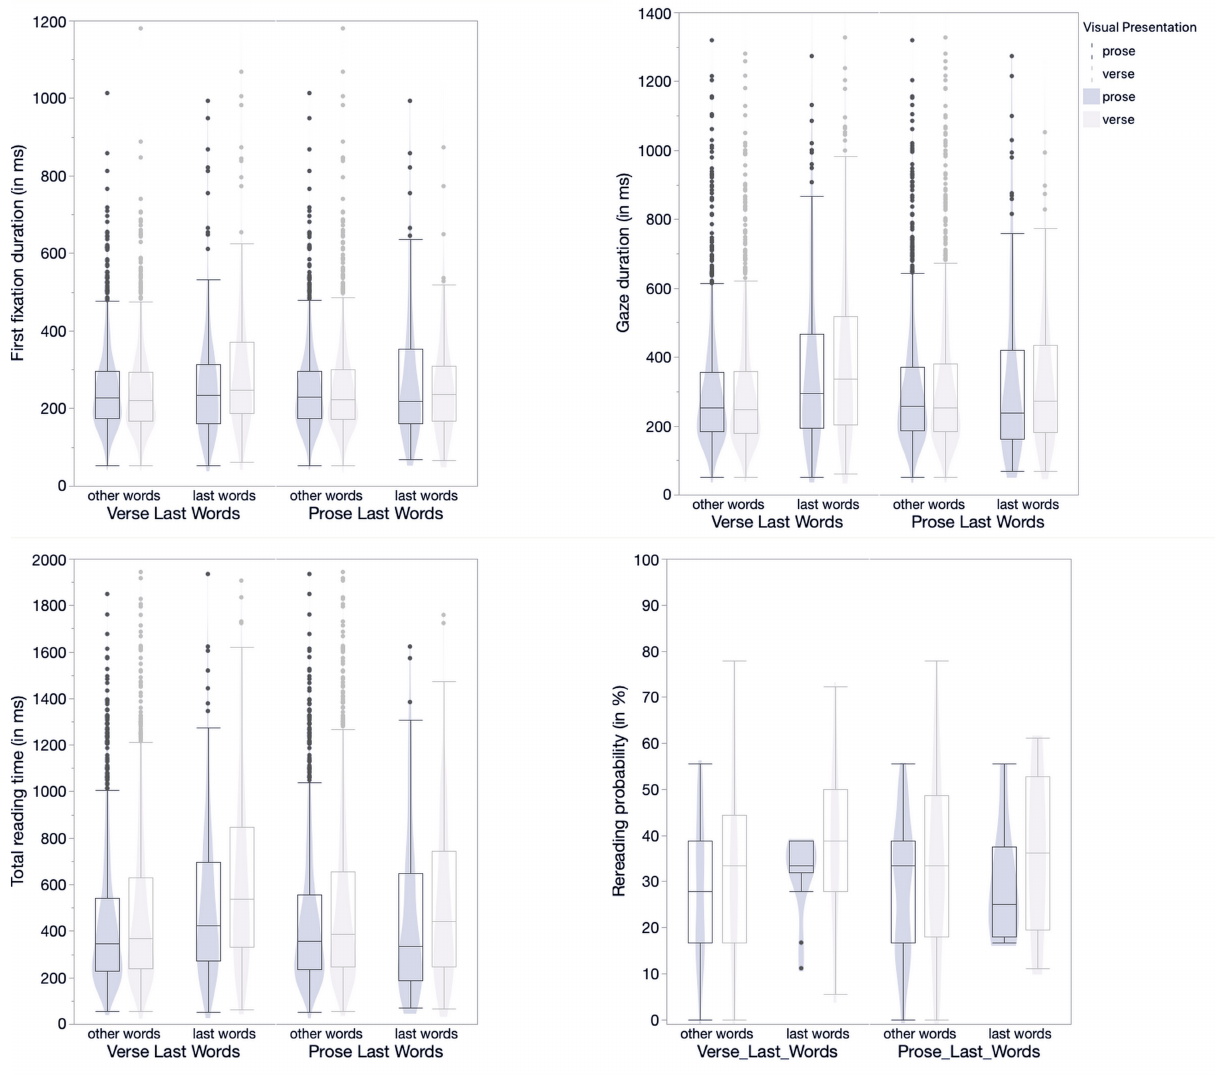
Figure 3. Violin plots and box plots showing the distribution of last words and other words for verse and prose for first fixation dura- tion (top left), gaze duration (top right), total reading time (bottom left), and rereading probability (bottom right). For the three dura- tion-based measures extreme values were excluded (0.5% of the